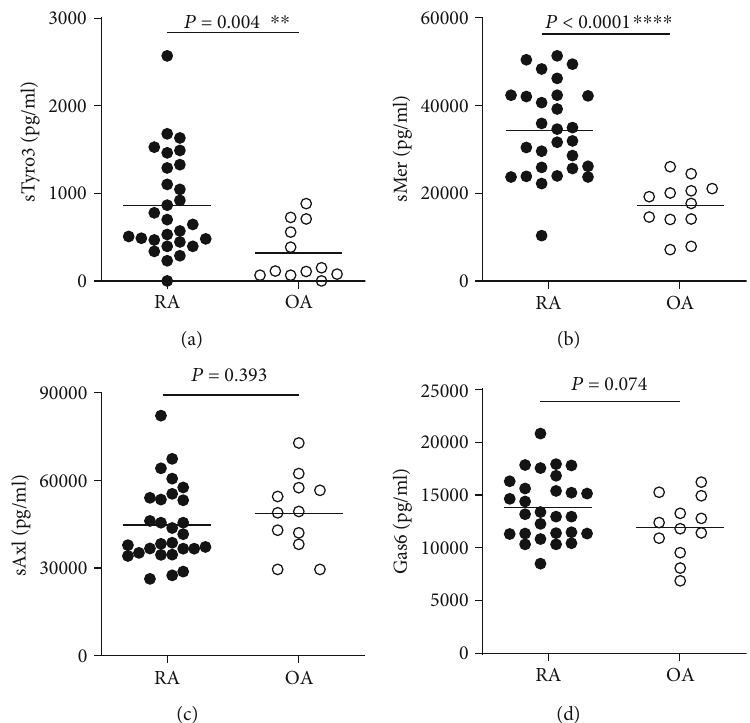
Figure 2: Soluble TAM receptors and Gas6 levels in the synovial fl uid of rheumatoid arthritis and osteoarthritis patients. Soluble Tyro3 (sTyro3) (a), soluble Mer (sMer) (b), soluble Axl (sAxl) (c), and Gas6 (d) levels in the synovial fl uid of rheumatoid arthritis (RA) ( n = 28 ) and osteoarthritis (OA) ( n = 12 ) patients were detected by ELISA. Data are presented as dot plots with mean tested by unpaired t -tests. ∗∗ P < 0 : 01 ; ∗∗∗∗ P < 0 : 0001